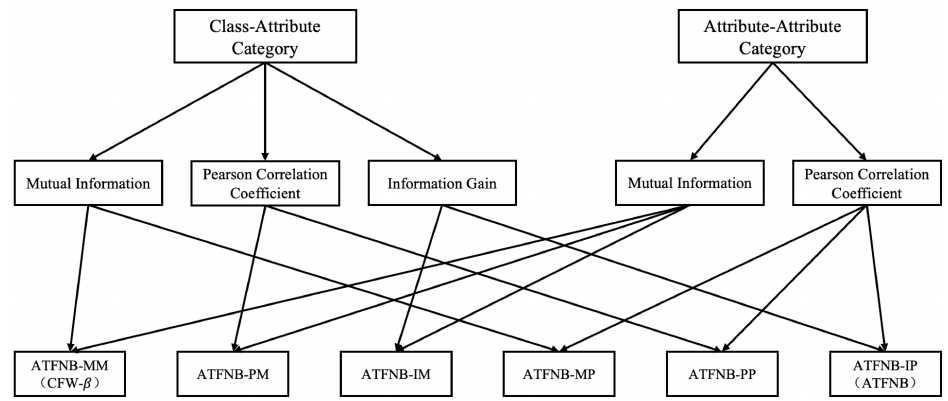
Figure 3. The index selection of each